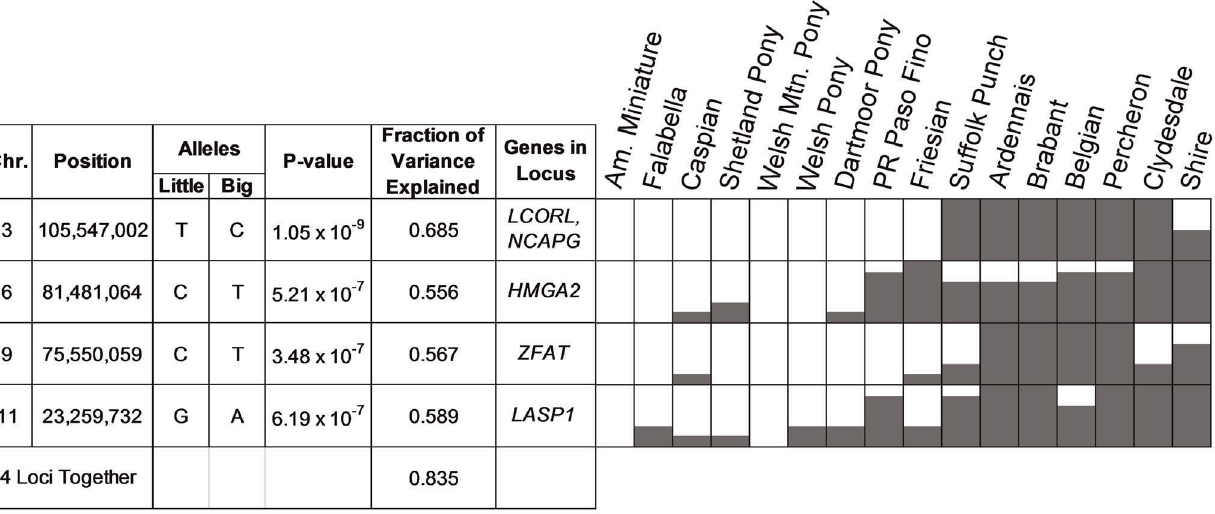
Figure 2. The 16 breed GWA scan identifies four loci associated with horse size. On the right the breeds are shown in size order. For each locus and breed the dark column in the cell indicates the frequency of the allele that is associated with large size.